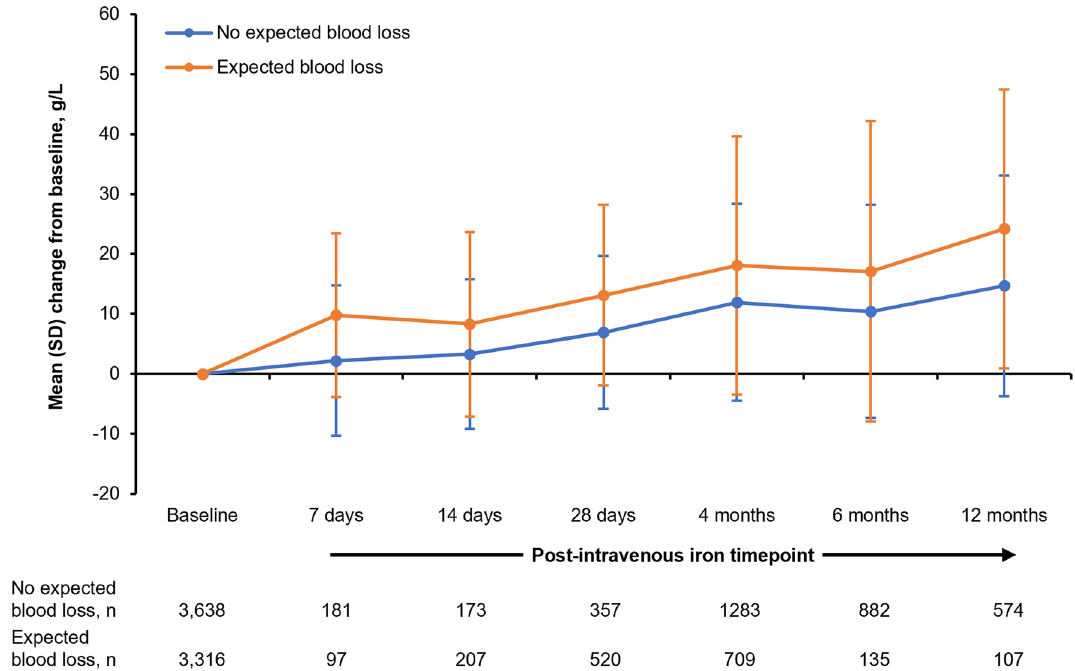
Figure 3. Change in haemoglobin following first course of FDI, according to the expectation of blood loss. Baseline mean (SD) data for ‘Expected blood loss’: haemoglobin = 101.3 (15.97) g/L; baseline mean (SD) data for ‘No expected blood loss’: haemoglobin = 98.0 (18.76) g/L. ‘Expected blood loss’ includes the specialties of surgery and obstetrics; ‘No expected blood loss’ includes all other hospital specialties. In both groups, the increase in haemoglobin between baseline and Month 4 was statistically significant (p < 0.0001). SD standard